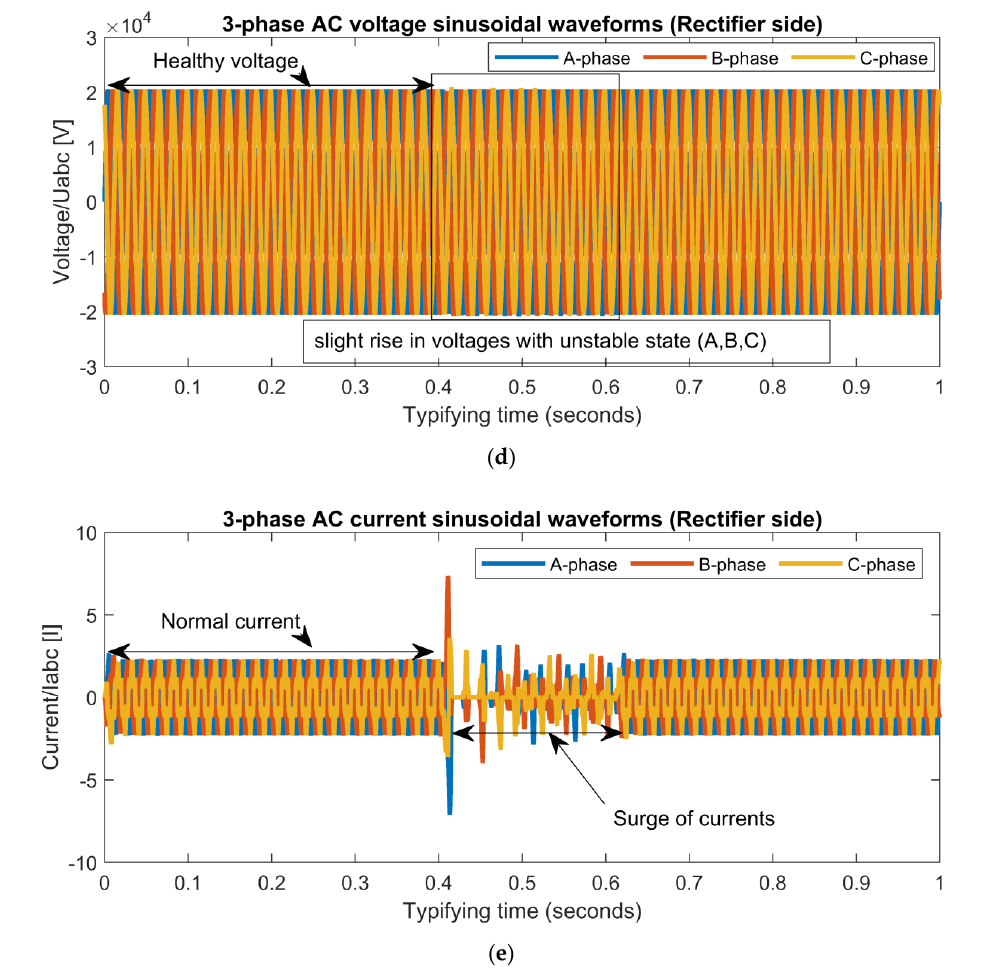
Figure 6. During a double phase-to-ground fault at station 2, simulation results for the HVDC system were obtained. ( a ) Three-phase AC voltages at the inverter side. ( b ) Three-phase AC currents at the inverter side. ( c ) DC line voltage. ( d ) Three-phase AC voltages at the rectifier side. ( e ) Three-phase AC currents at the rectifier side.